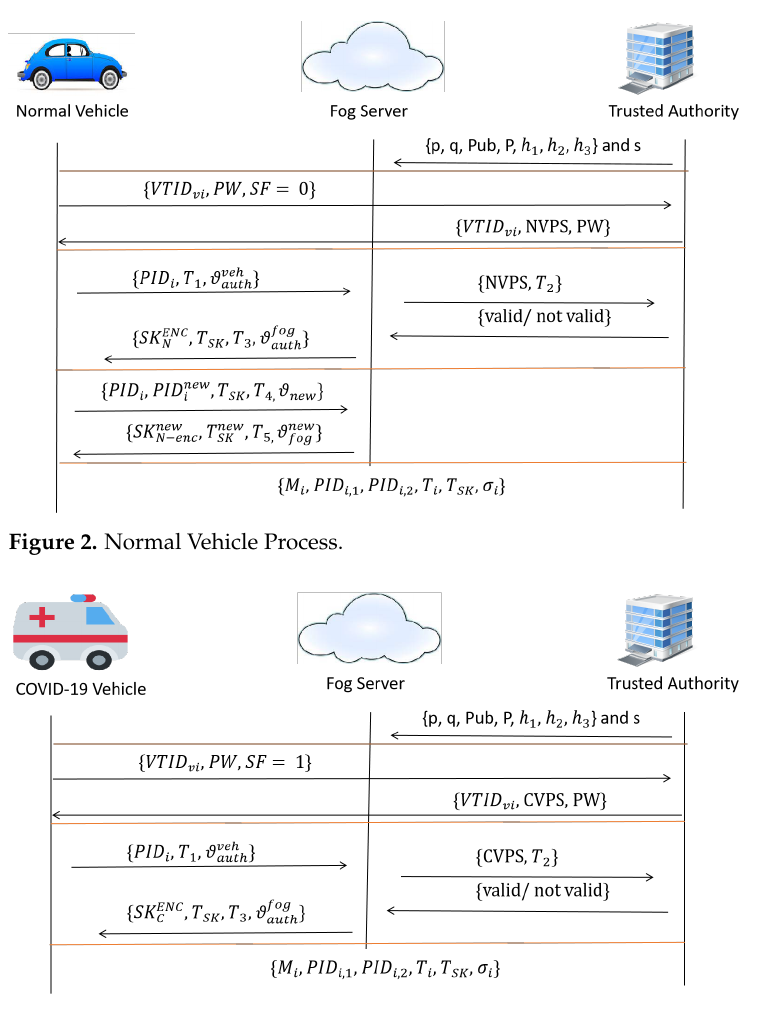
Figure 3. COVID-19 Vehicle